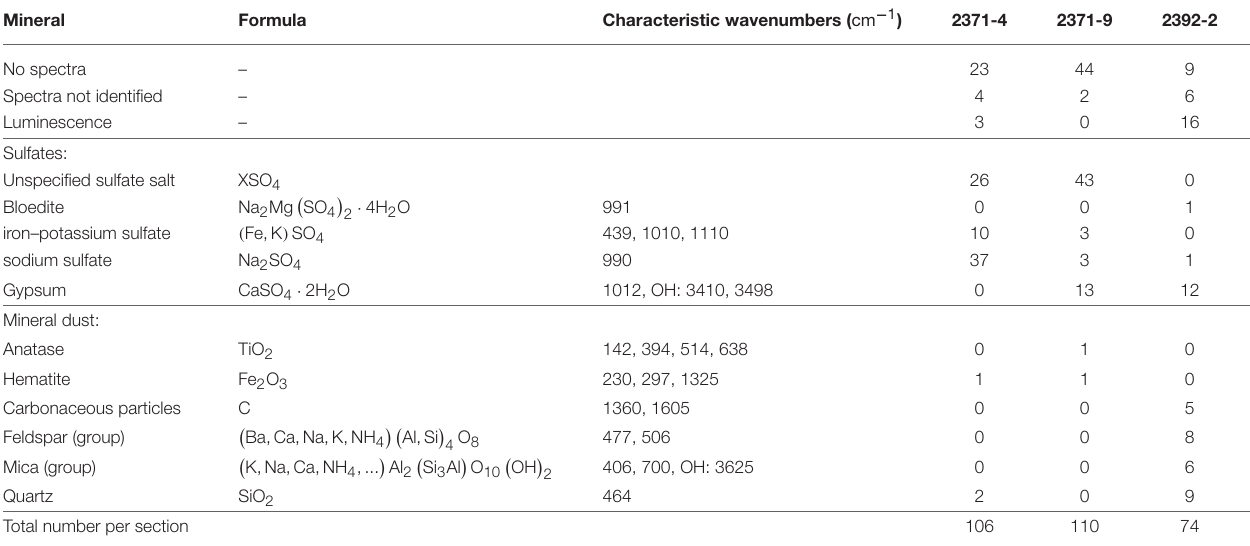
TABLE 1 | Raman spectra of micro-inclusions detected in the analyzed ice sections. Mineral